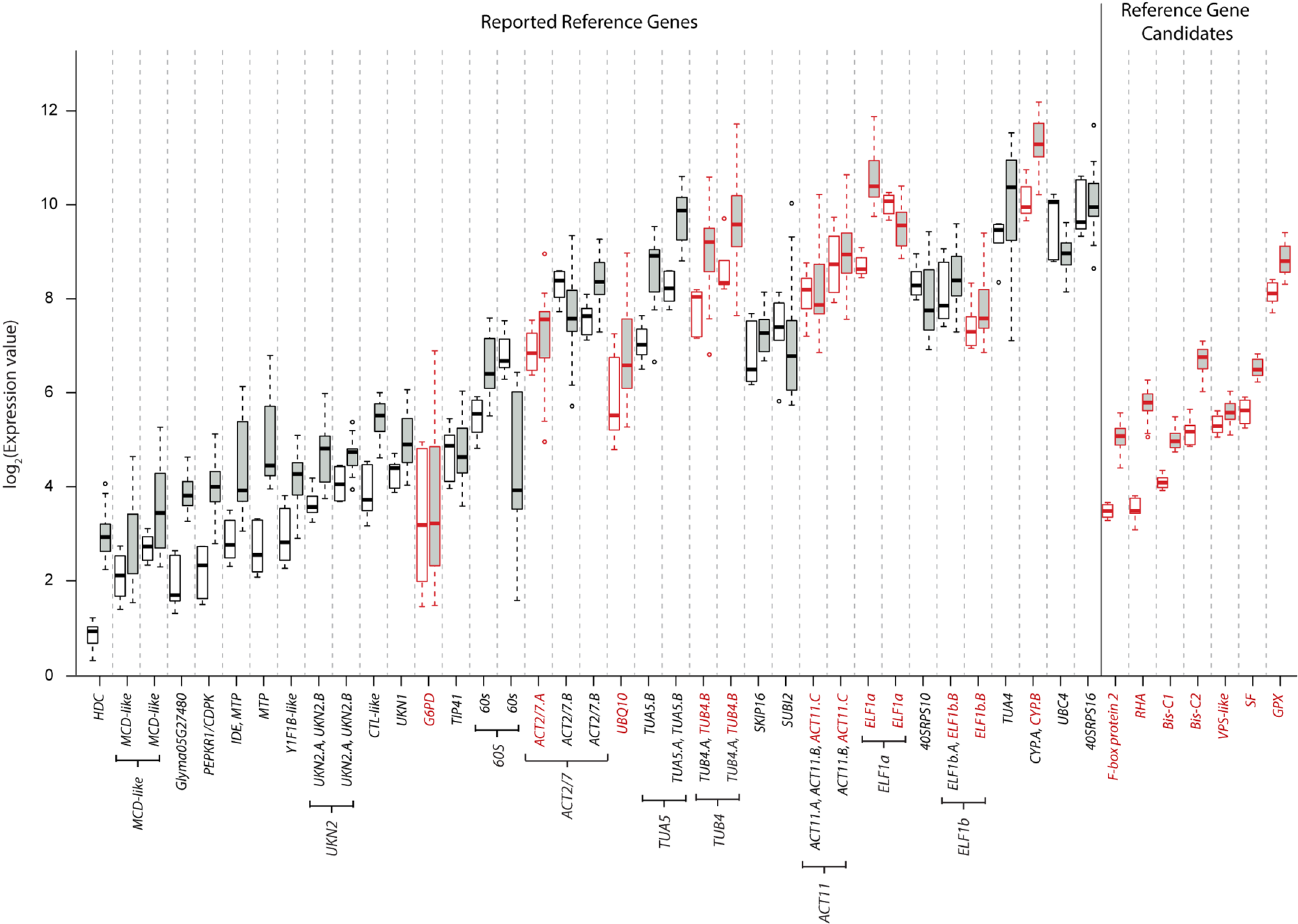
Fig 1. Evaluation of previously reported reference genes and new candidate reference genes. A boxplot of RNA-Seq data showing the expression levels of 37 previously reported primer sets from 28 known reference genes and 7 new candidate reference genes. The expression level of each target was shown. White boxes: Group 1 RNA-Seq data; Grey boxes: Group 2 RNA-Seq data. Primer sets with multiple targets were marked with brackets. Primer sets marked in red were chosen for RT-qPCR validation.